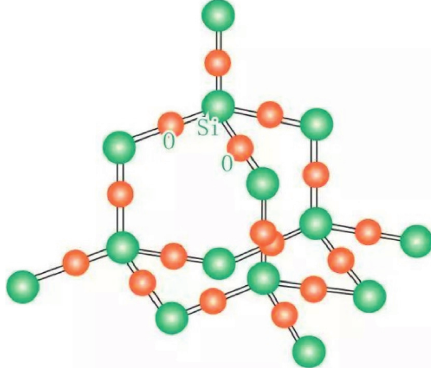
Figure 6: Unit cell of silica.